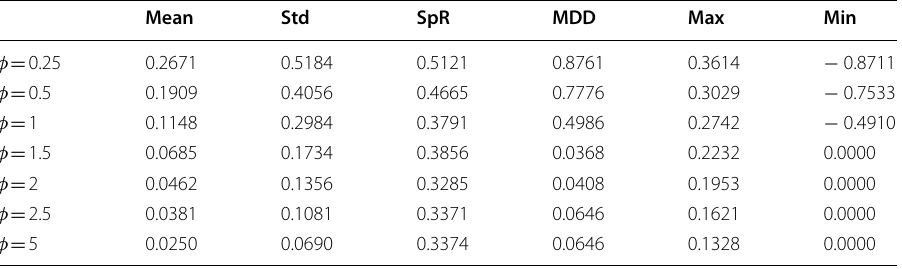
Table 7 The relationship between risk preference and out-of-sample performance of risk- free